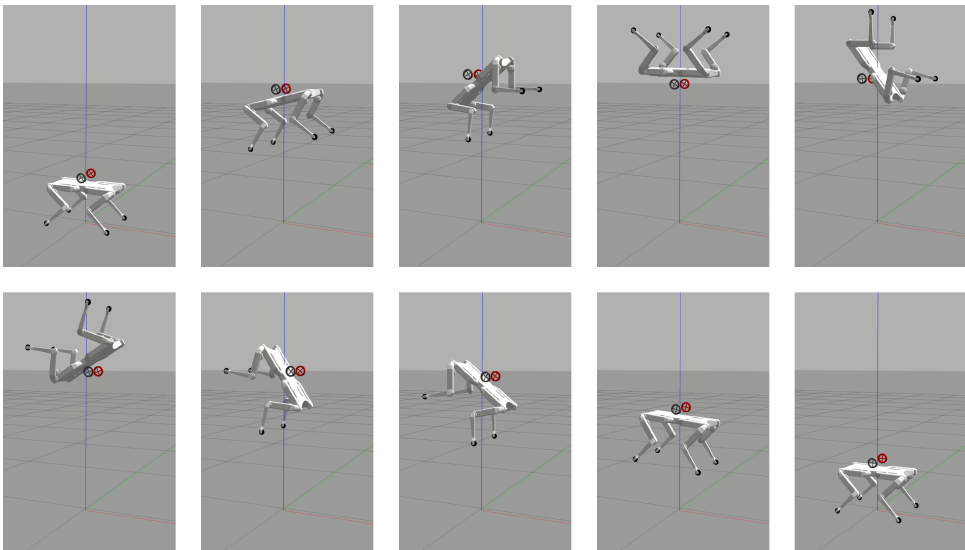
Figure 10. Third Test: sequence of snapshots of Solo12 performing a back-flip in the Gazebo environ- ment. The OCS alleviated the effort requested of the leg joints, that, in this case, could only be used to accomplish the vertical motion. The red, green and blue lines represent the axes of the inertial (world) reference